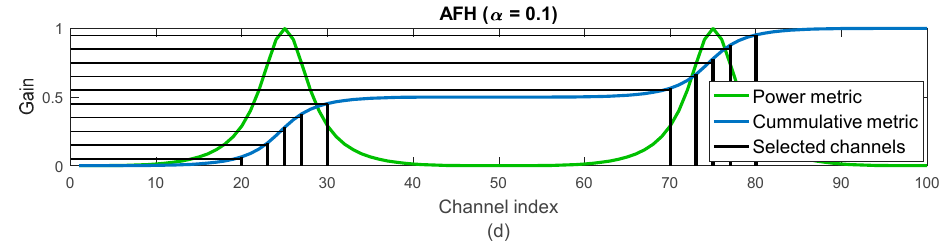
Figure 8. Comparison of channel selection between different frequency hopping techniques: ( a ) Highest Gain Frequency Hopping (HGFH); ( b ) Matched Frequency Hopping (MFH); ( c ) Clipped Matched Frequency Hopping (CMFH) with ξ = 0.1; ( d ) Advanced Frequency Hopping (AFH) with α = 0.1. The selected channels are represented as vertical black lines. HGFH directly uses the channel gain (red) to select the best channels, while MFH, CMFH and AFH use the cumulative metrics (blue) obtained from the power metrics (green) and their intersections with the equally spaced horizontal lines.